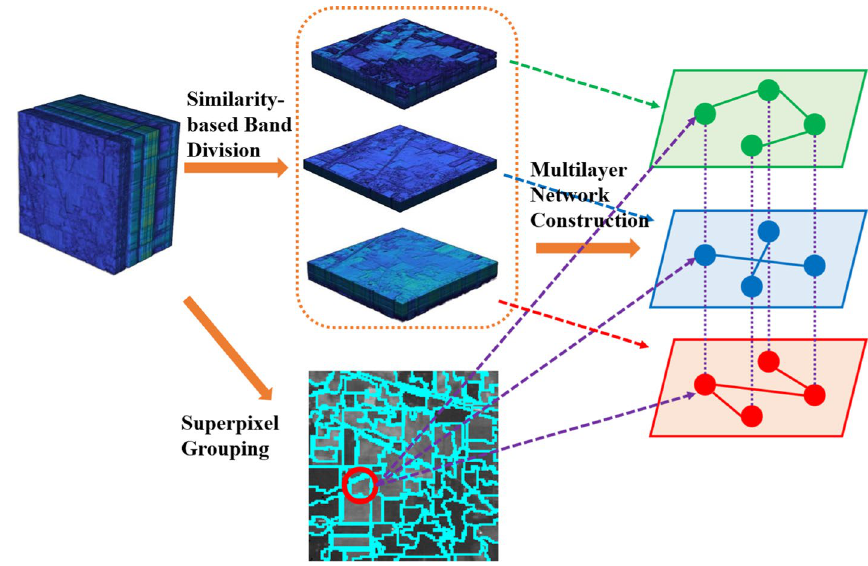
Fig. 2 Scheme of MLG-based unsupervised HSI